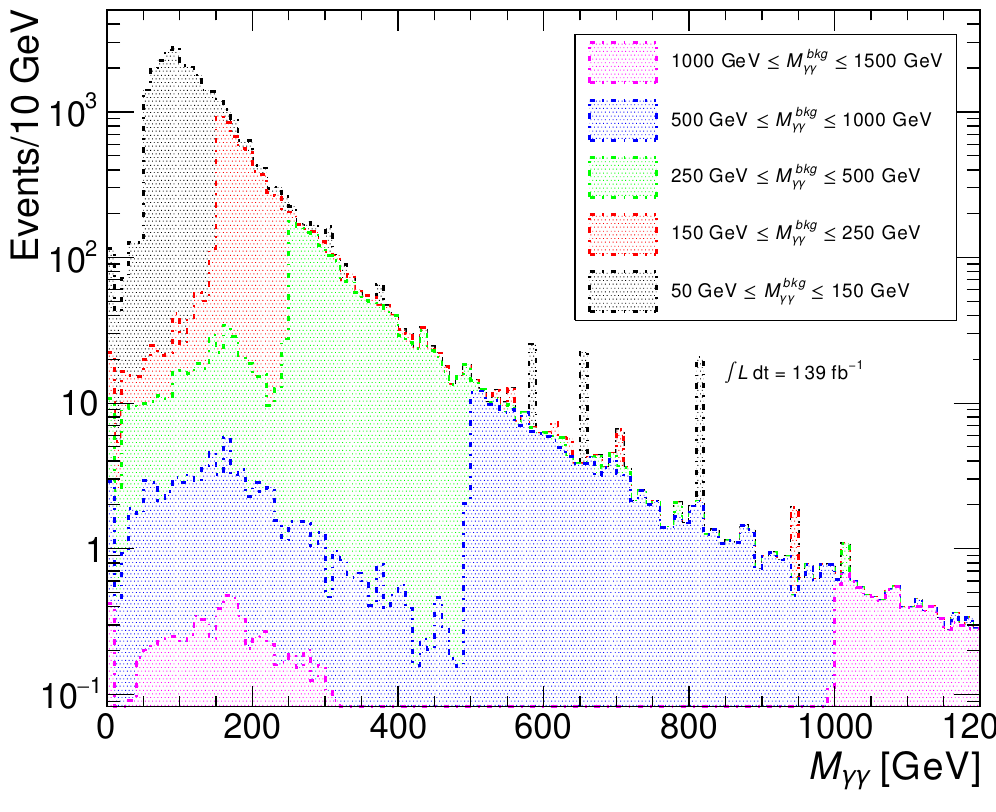
Figure 5 . Invariant mass M (cid:13)(cid:13) of the photon pair at reconstructed level for each M bkg (cid:13) (cid:13) + jets background. At least two photons and one b -jet, as de(cid:12)ned in section 4.1, are required. The contributions from the slices are stacked.